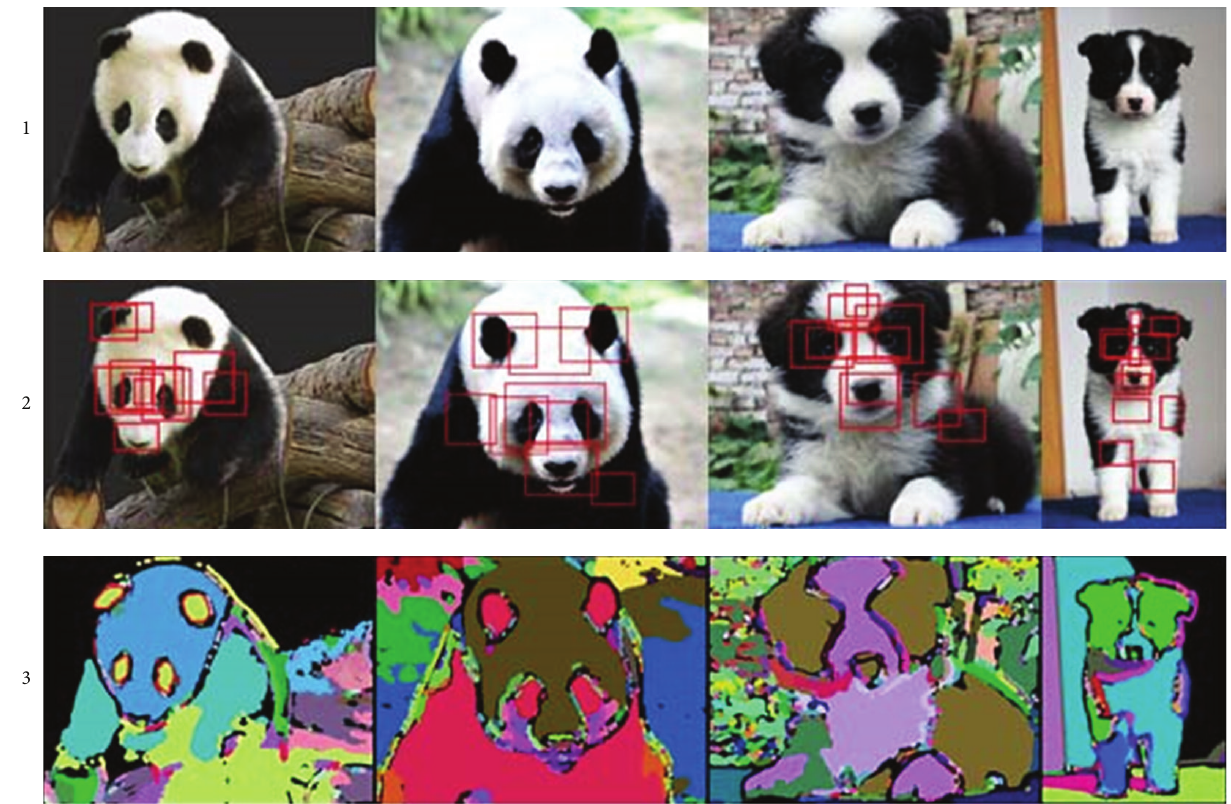
Figure 10: Discriminative patterns and PatchNet map. Table 1: The accuracy of our method and the method of literature [5].